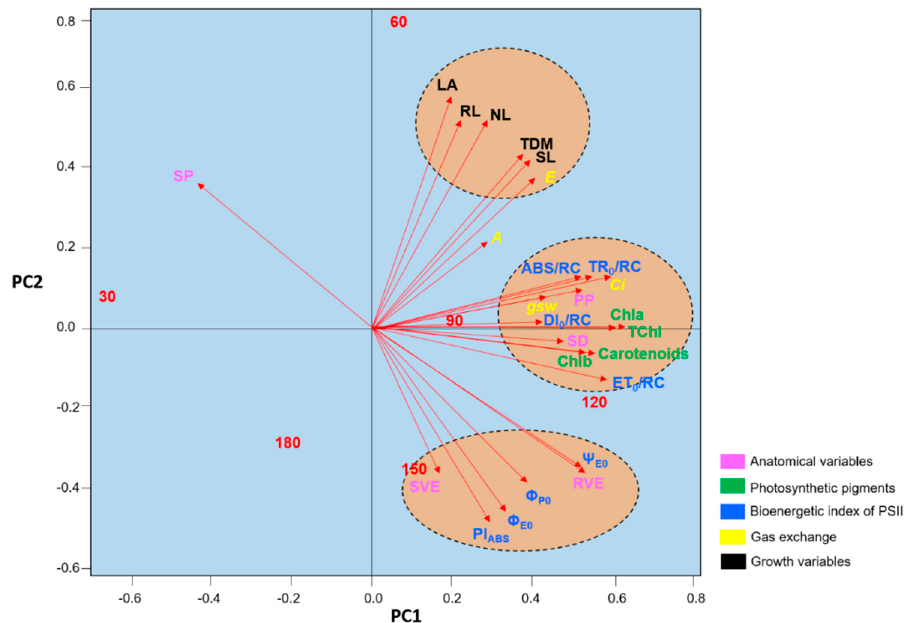
Figure 10. Plot of the results of the principal components analysis of the anatomical variables, photosynthetic pigments, chlorophyll a fluorescence parameters, gas exchange, and growth of the seedlings of Hymenaea courbaril L. cultivated in a hydroponic system and sampled at 30-day intervals across their initial development (30, 60, 90, 120, 150, and 180 days after transplantation).